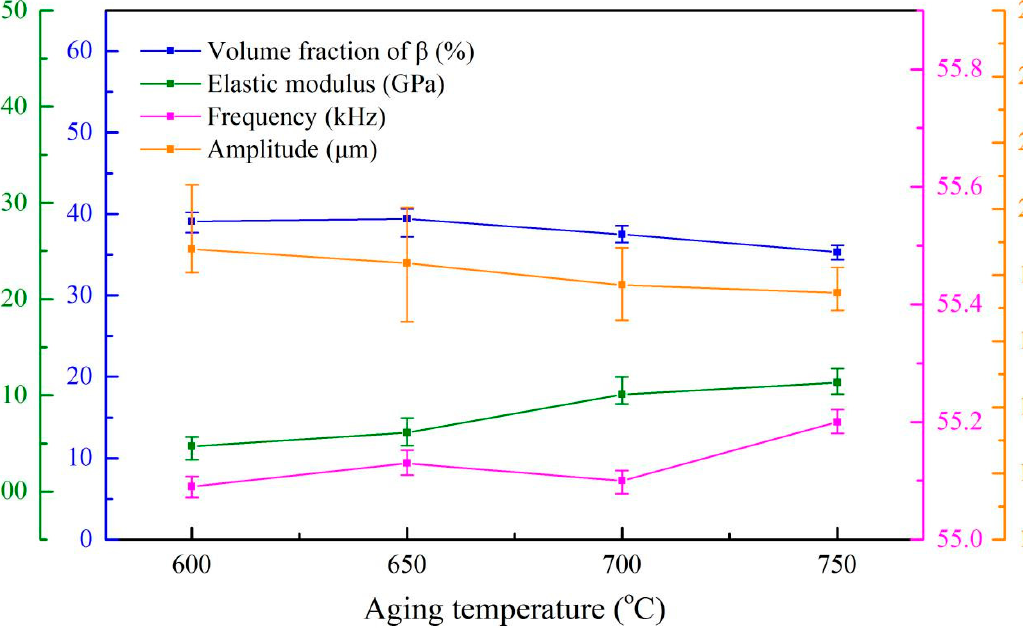
Figure 12. The relationship between β phase content, the elastic modulus, the ultrasonic resonant frequency and the amplitude of Ti6Al4V alloy under different aging temperature.